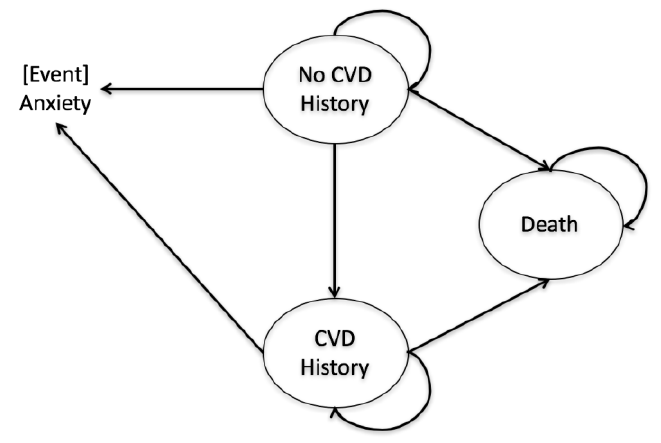
Figure 2. Markov model diagram.